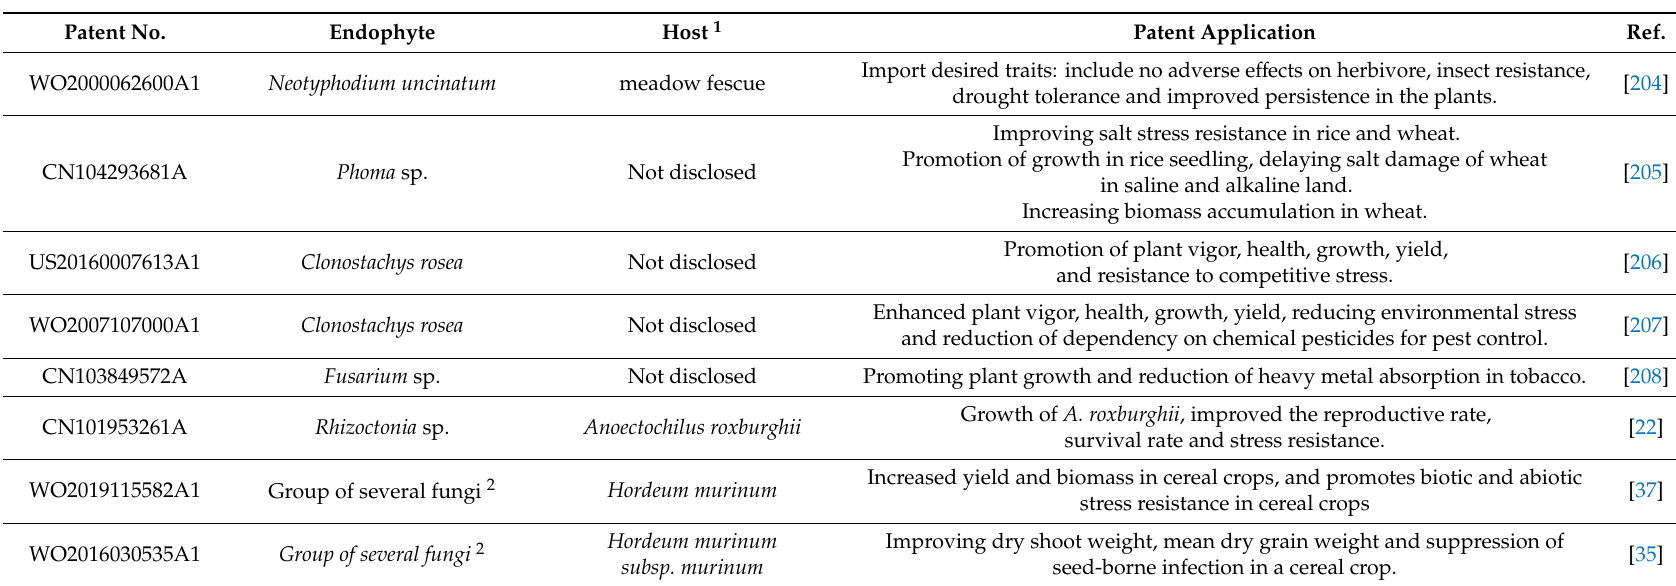
Table 5. Patents that claim multiple